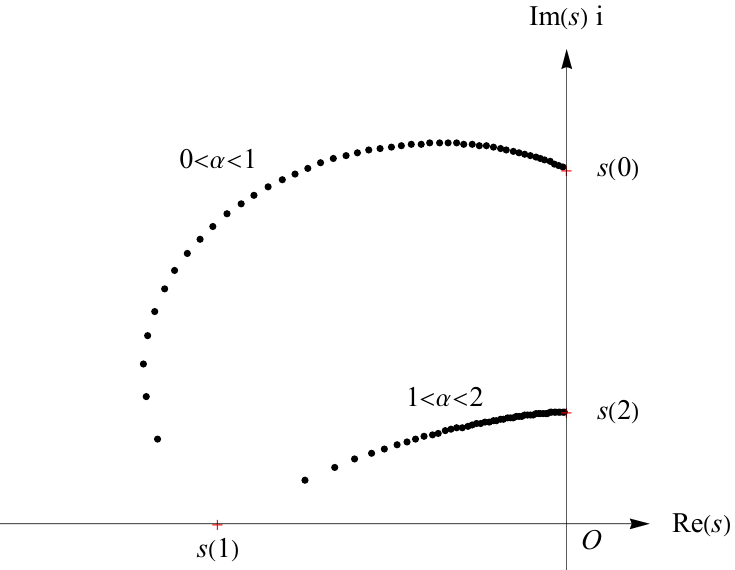
Figure 7. Trajectory of roots s ( α ) for α varying between 0 and 2, where b = 4 and c = 4 ( b 2 − 4 c = 0 ) .